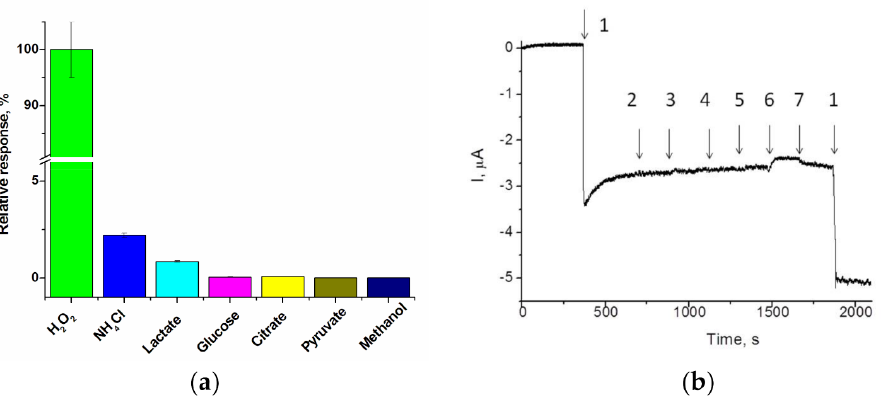
Figure 4. The selectivity tests for gCuHCF/GE: ( a )—current responses in relative units (%), on the added analytes up to 2 mM concentration, as a ratio of the detected signals to the value of the highest current response; ( b )—chronoamperograms as outputs on the added analytes (1–7) up to 0.5 mM concentration: (1)—H 2 O 2 , (2)—glucose, (3)—glycerol, (4)—methanol, (5)—sodium citrate, (6)—sodium lactate, (7)—ammonium chloride. Conditions: working potential − 50 mV vs. Ag/AgCl (reference electrode), 50 mM NaOAc buffer, pH 4.5 at 23 ◦